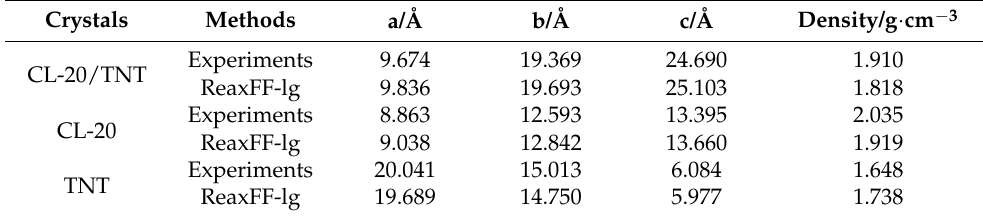
Table 1. Comparison of lattice parameters and density of three relaxed crystals.